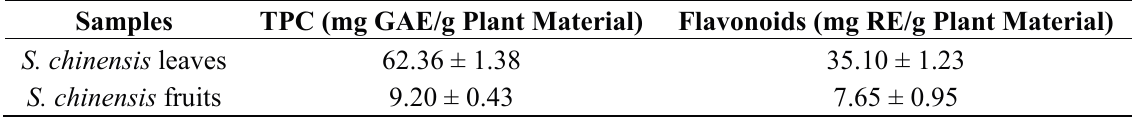
Table 2. The content of total polyphenols and flavonoids in the extracts. Samples